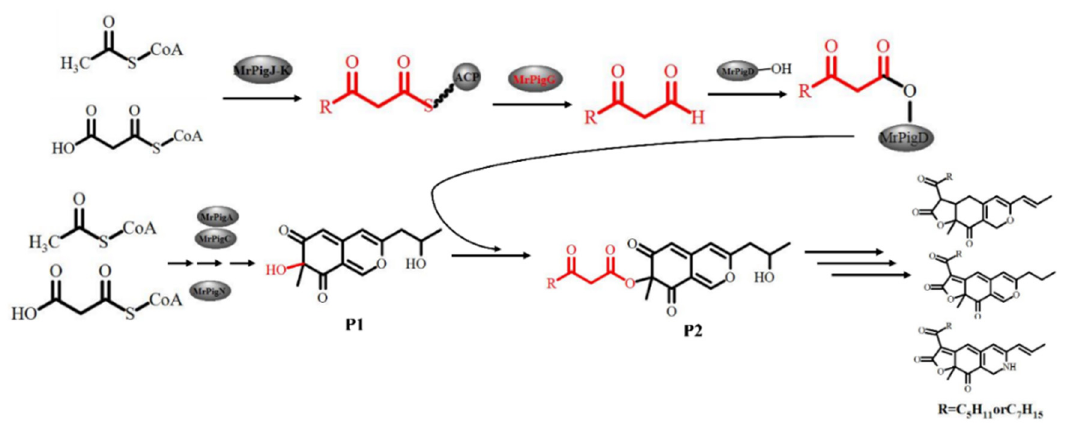
Figure 8. Proposed pathway involving the MrPigG protein.